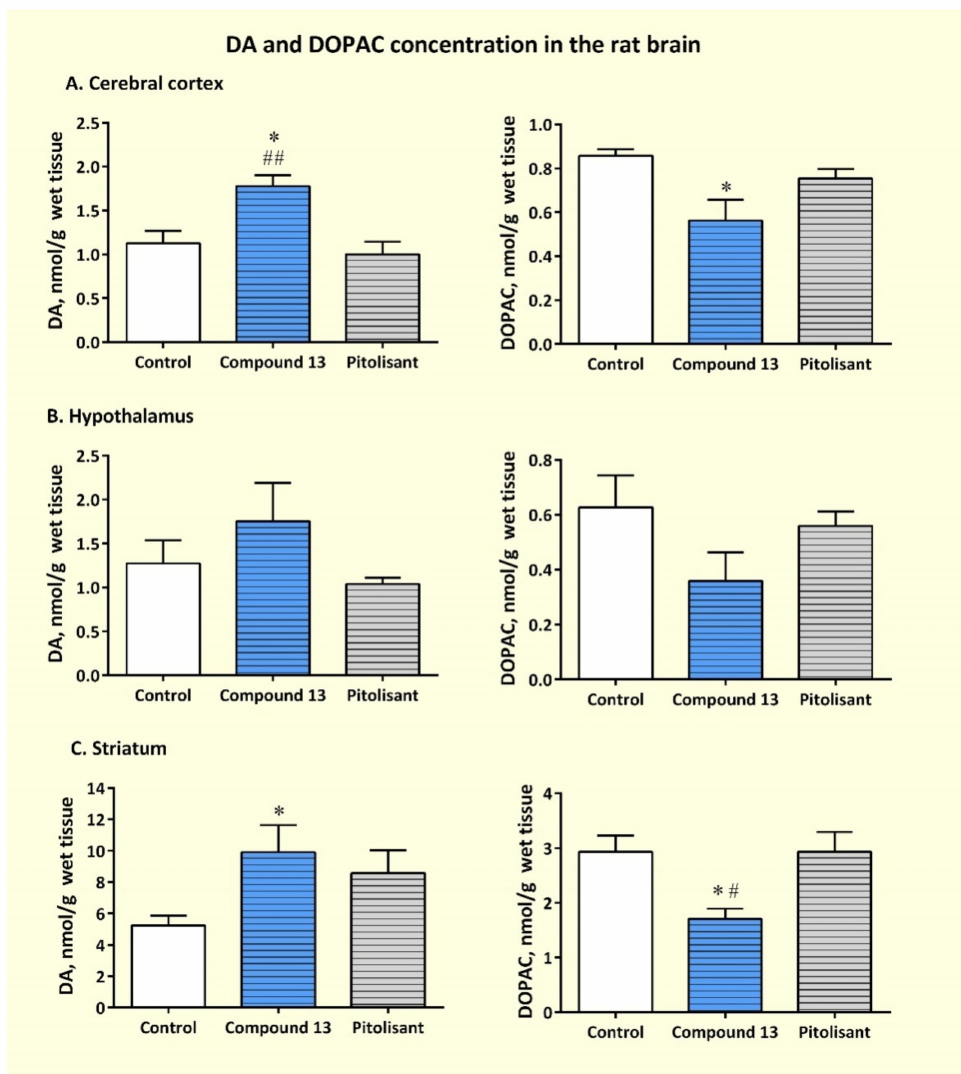
Figure 9. Concentrations of DA and DOPAC in brain regions of rats sub-chronically treated with compound 13 and pitolisant (DA—dopamine, DOPAC—3,4-dihydroxyindoleacetic acid). The drugs (both in a dose of 3 mg/kg of body mass) were injected subcutaneously for 6 consecutive days. Values are expressed as nanomoles per gram wet weight and are means ± SEM (n = 7–8). One-way ANOVA and Tukey’s multiple comparisons test: * vs. control, # vs. pitolisant. One symbol means p < 0.05, while two symbols p <